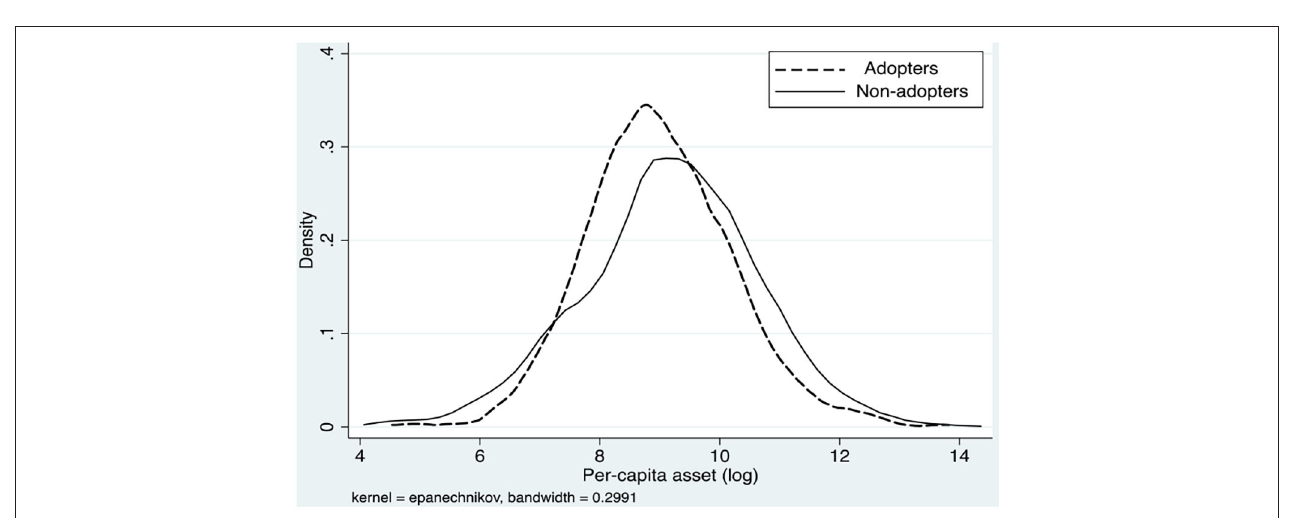
FIGURE 3 | Kernel density distribution of the log of per-capita asset value for adopters and non-adopters of organic fertilizers.